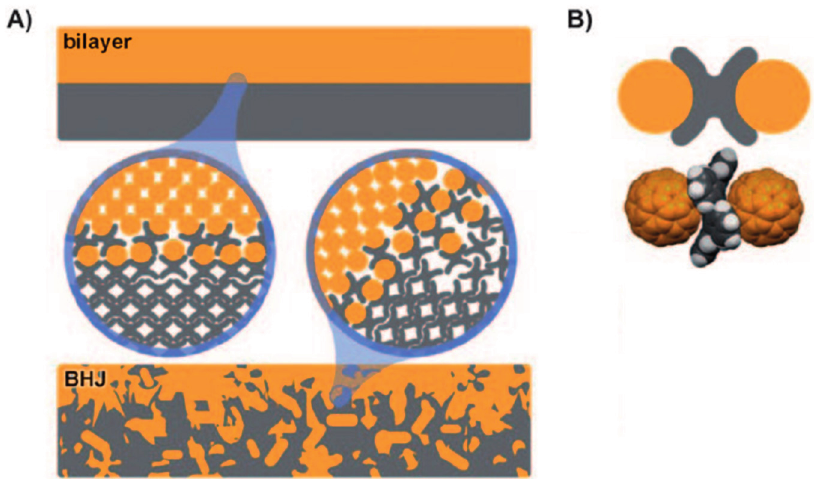
Figure 14. ( A ) Depiction of ball-and-socket interfaces in bilayer and bulk-heterojunction devices; ( B ) schematic depiction and molecular structure of the interface between c-HBC and C 60 . Adapted from [157] with permission from John Wiley and Sons.